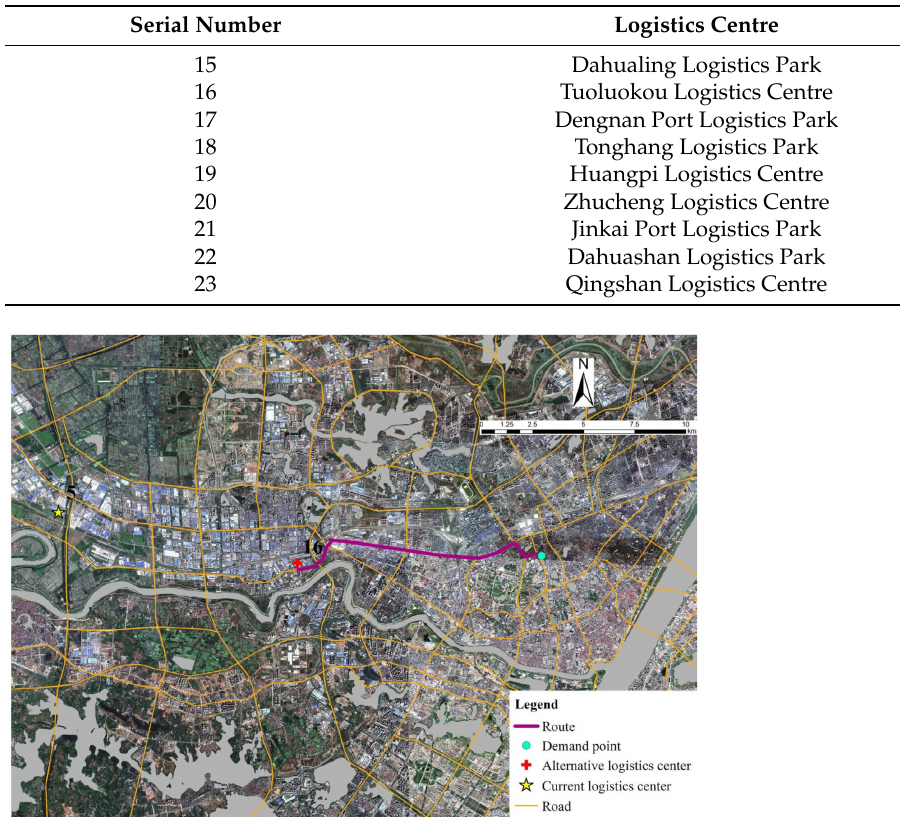
Figure 7. Selection of the nearest LCS based on distance from the road network. Table 4. The alternative facilities in Wuhan.